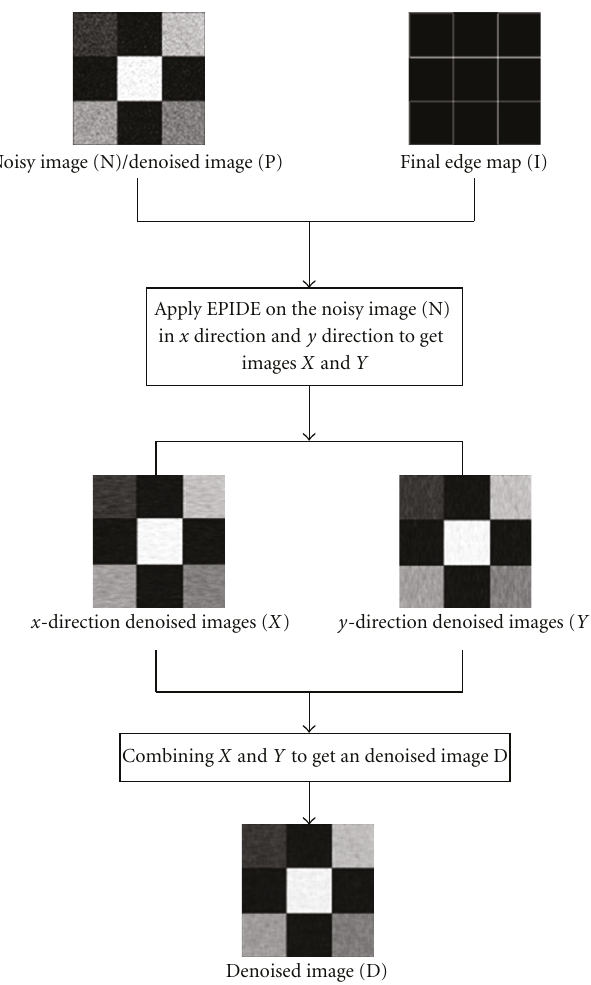
Figure 6: The flow chart to get denoised image at the final